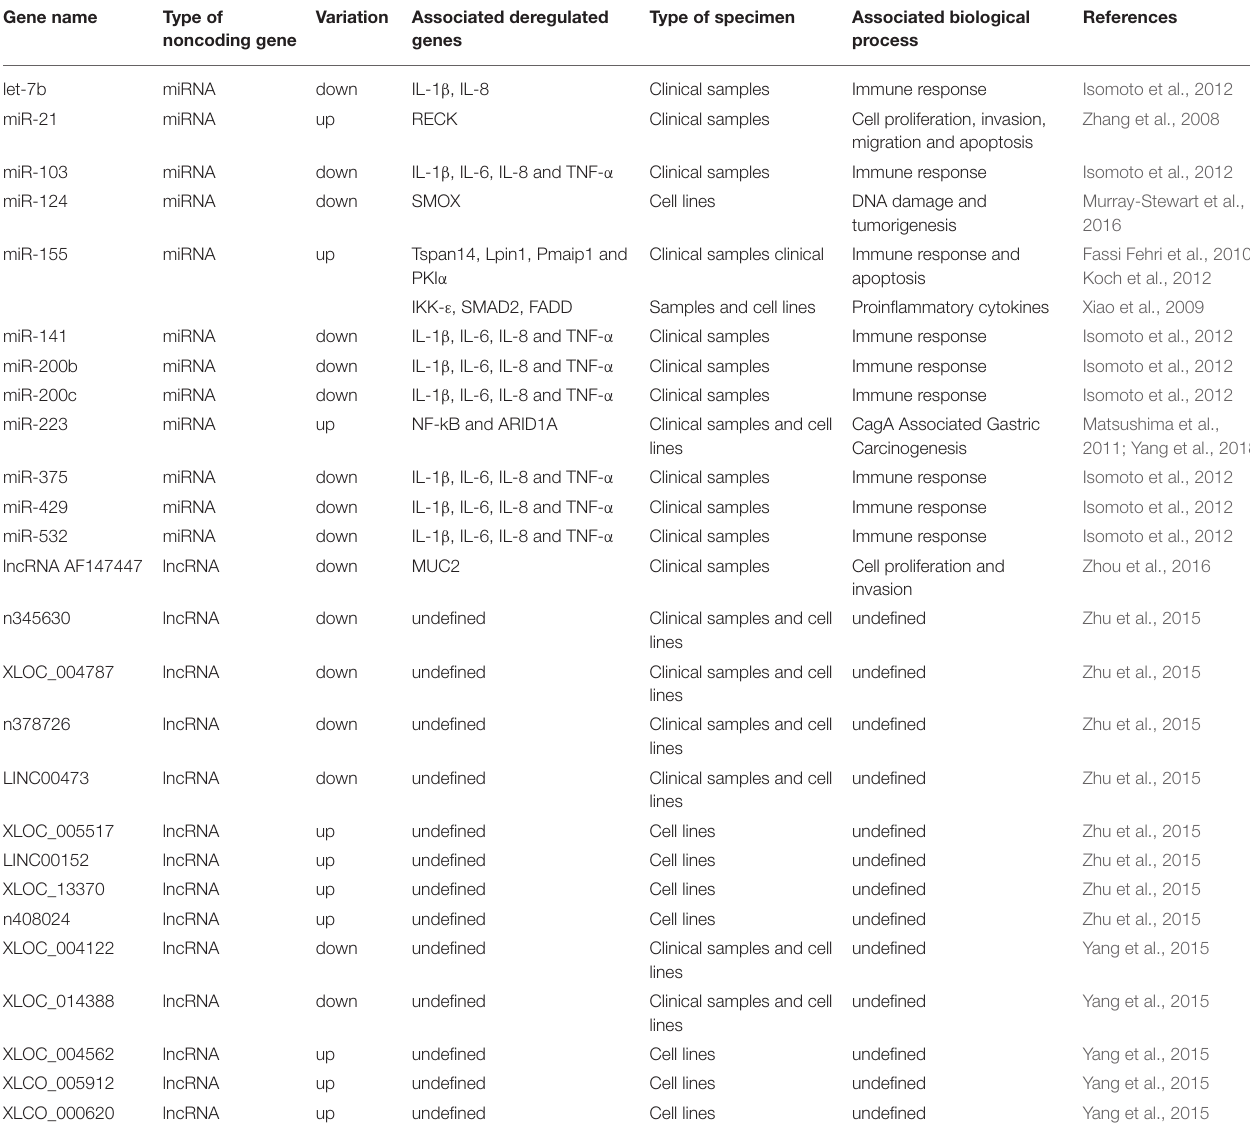
TABLE 1 | Deregulated host miRNAs and lncRNAs in H. pylori